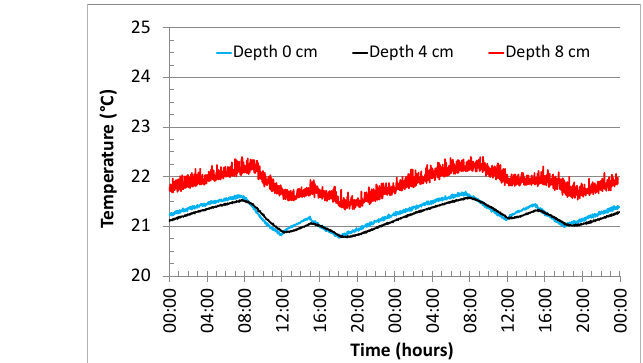
Figure 14. Measured slab temperatures for Scenario I ( left ) and Scenario II ( right ) of the lab test.